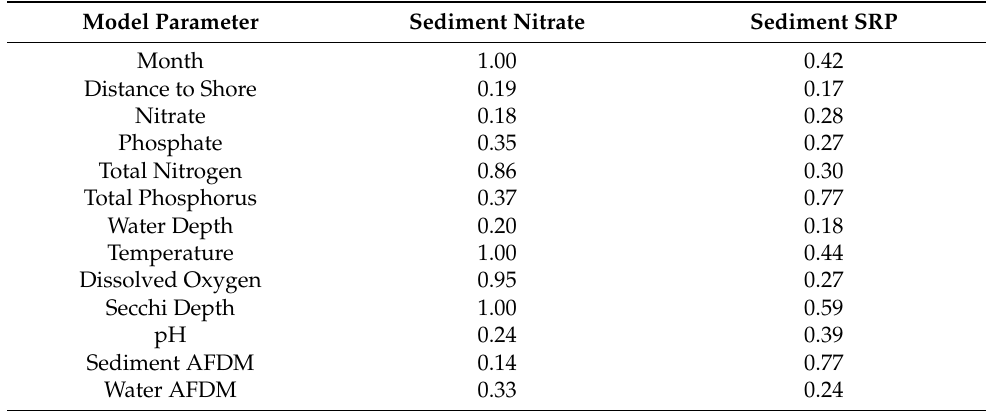
Table 3. Relative importance of each model parameter on sediment nitrate and soluble reactive phosphorus flux rates. These values are the cumulative Akaike information criterion for small sample size (AICc) weights for each variable. Parameters that increase with increasing sediment nutrient uptake (negative flux rates) are in